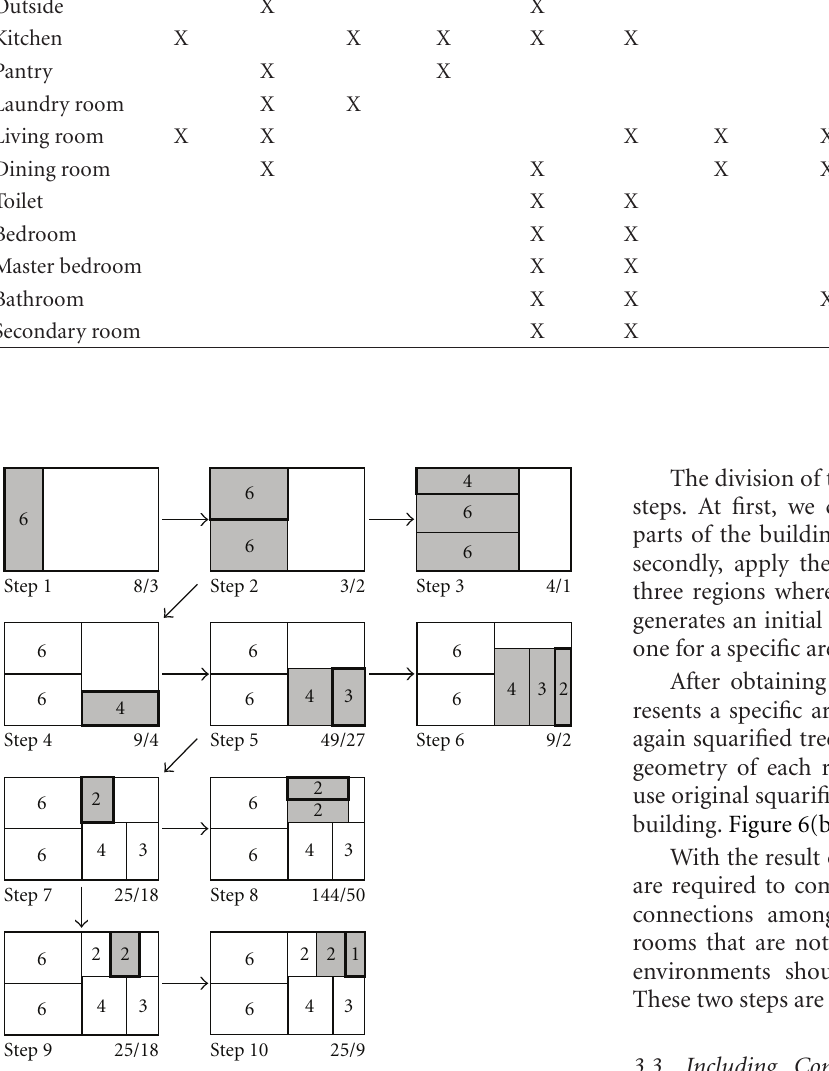
Figure 4: Example of squarified treemap process